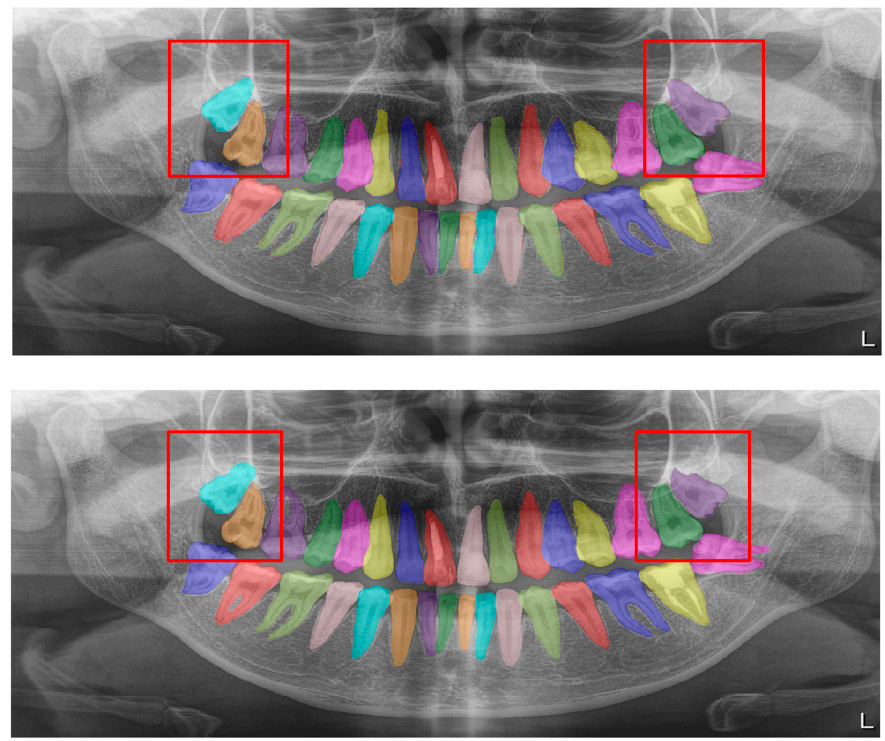
Figure 8. Erroneous automatic segmentation at the maxillary left third molar due to the superimpo- sition between the maxillary sinus floor and root apices of the tooth. Manual segmentation (upper image) and automatic segmentation (lower image) can be seen above.